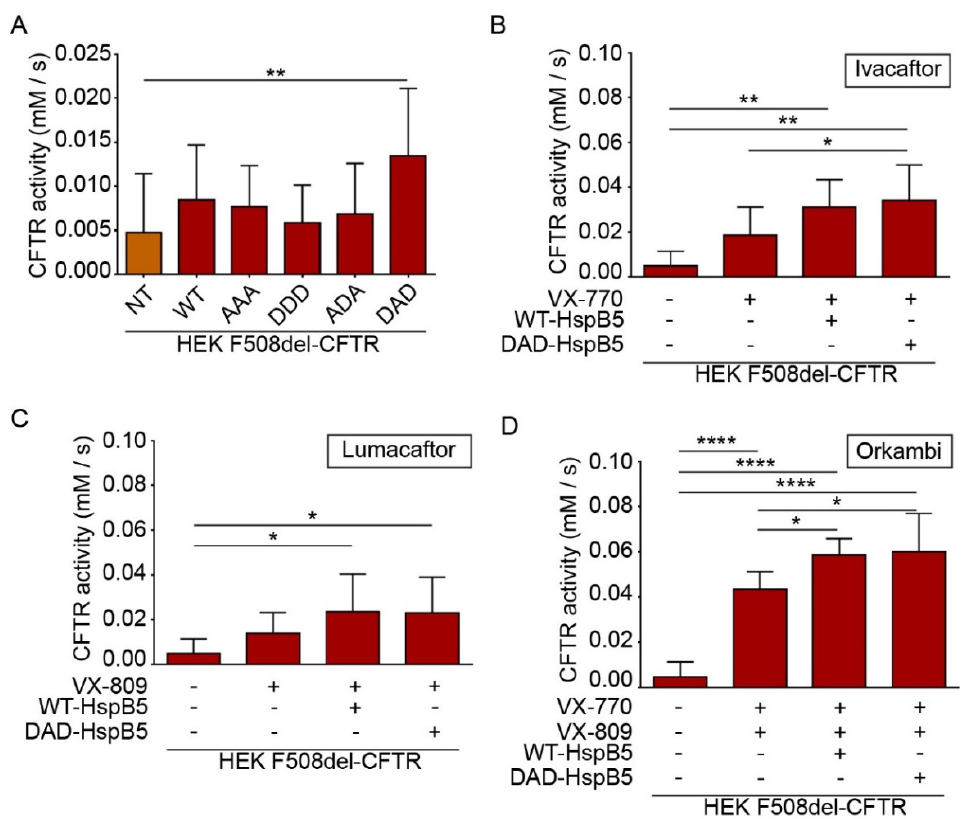
Figure 6. HspB5 and its phosphomimetic DAD mutant increased the F508del function and acted in synergy with Ivacaftor and Orkambi treatments. HEK293 MSR GripTite cells stably coexpressing eYFP (H148Q / I152L) and F508del-CFTR-3HA were transfected with WT- or phosphomimetic-HspB5. Before halide transport assay to measure CFTR (or its mutant) function, untransfected cells (NT) were treated with 0.1% DMSO and transfected cells were treated, or not, with VX-770 (10 µ M–30 min), VX-809 (3 µ M–24 h), or combination VX-770 and VX-809 (24 h). Each condition was done in triplicate, and the experiments were repeated three times. * p < 0.05, ** p < 0.01, **** p < 0.0001. Differences were obtained using a one-way ANOVA followed by the post-hoc Dunnett test. ( A ) Halide transport assay in F508del-CFTR-3HA-eYFP-HEK transfected WT- or phosphomimetic-HspB5. ( B ) Halide transport assay in F508del-CFTR-3HA-eYFP-HEK transfected WT- or phosphomimetic-HspB5 and treated with VX-770. ( C ) Halide transport assay in F508del-CFTR-3HA-eYFP-HEK transfected WT- or phosphomimetic-HspB5 and treated with VX-809. ( D ) Halide transport assay in F508del-CFTR-3HA-eYFP-HEK transfected WT- or phosphomimetic-HspB5 and treated with VX-770 and